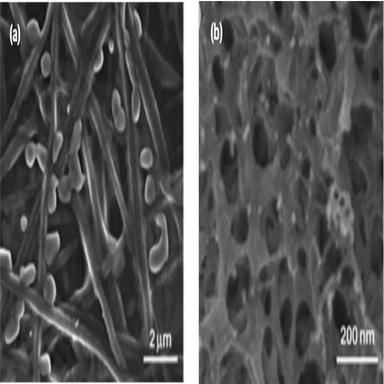
(a) E.coli retained by the membrane. (b) MS2 virus adsorption to the surface of the membrane.